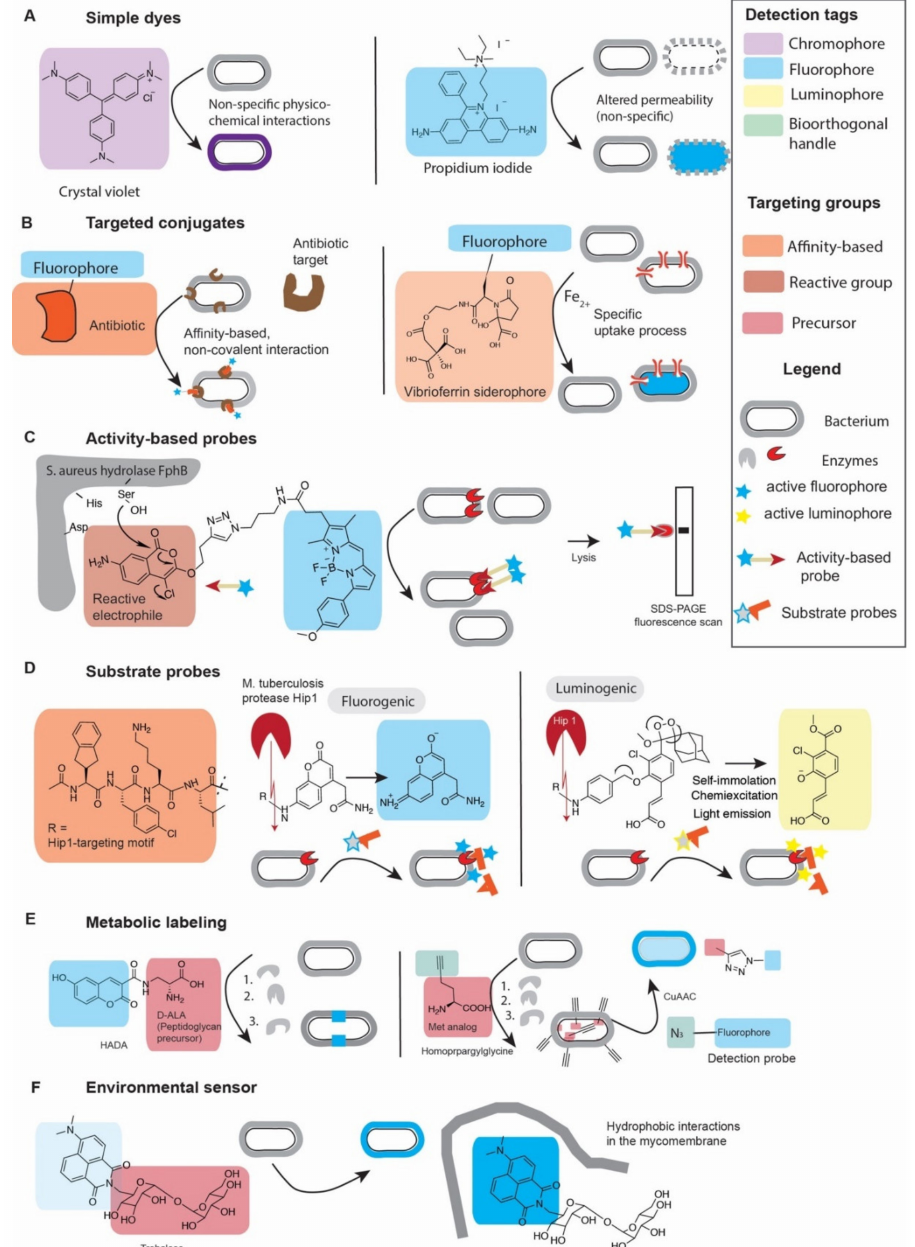
Figure 1. Illustrations of di ff erent types of chemical probes and their mode of action. ( A ) Simple dyes (such as crystal violet [57–59]) interact non-specifically with bacterial cells and stain cellular structures or are used to probe the permeability of the bacterial cell envelope (propidium iodide) [5,6]. ( B ) Targeted fluorescent conjugates as exemplified as antibiotic-conjugates and siderophore-based uptake probes [60]. ( C ) Activity-based probes are functionalized covalent enzyme inhibitors that